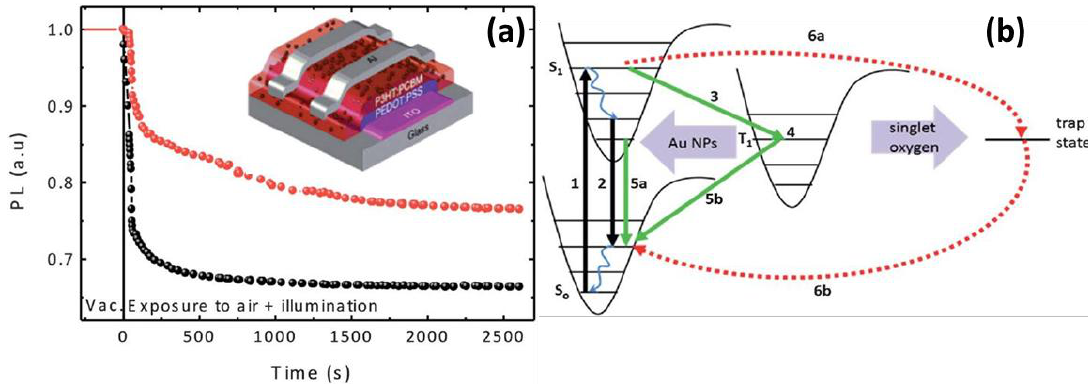
Figure 16. ( a ) PL decay measurements: comparison of the pristine (black) and NP-doped blend (red). The inset is the schematic device architecture of the solar cell. ( b ) Schematic of the photo-oxidation process in the polymer: Au NPs active layer. Energy from the polymer triplet excitons excites singlet oxygen, which reacts with the polymer chains to form exciton trap states. The Au NPs embedded into the blend act as quenchers of the triplet excitons, and in this way the photooxidation process can be impeded. (1) Absorption; (2) luminescence; (3) system intercrossing; (4) triplet state; (5a, 5b) triplet quenching; (6a, 6b) exciton recombination via trap states. This process is limited in the presence of a triplet quencher [101]. Reprinted with permission from Ref. [101].